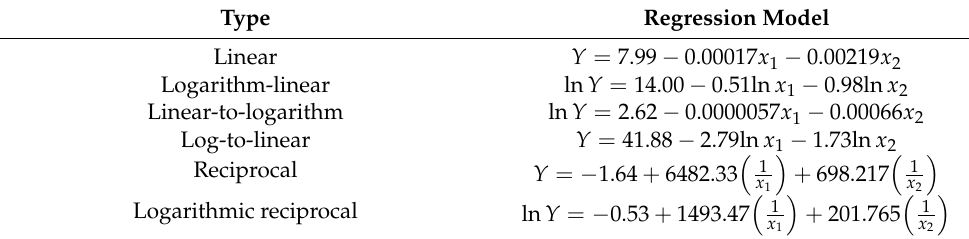
Table 5. The results of the regression